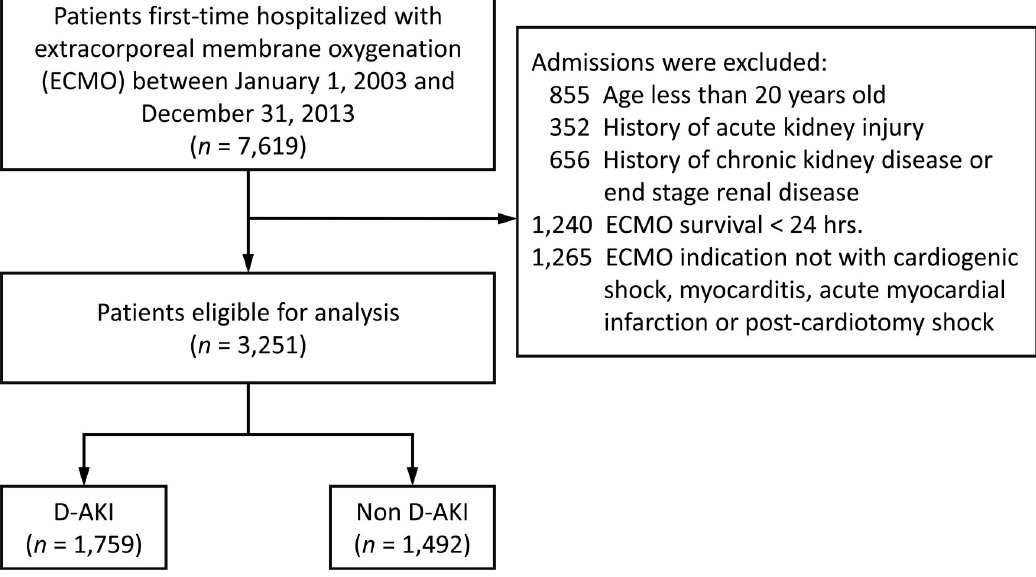
Fig 1. Patient’s inclusion